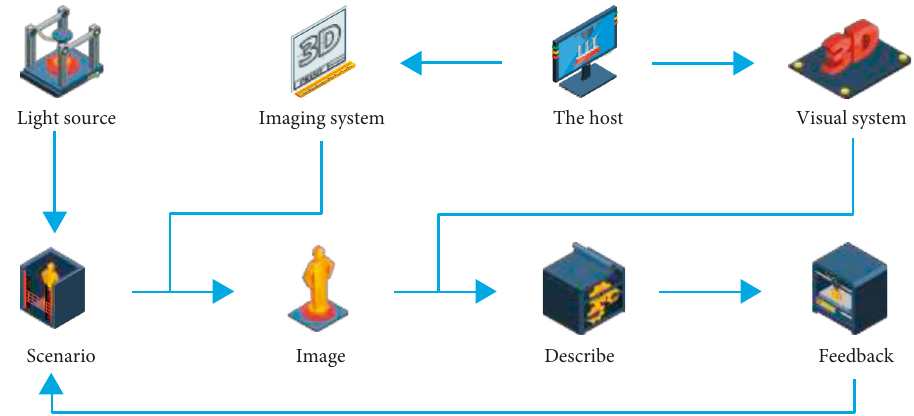
Figure 1: Design of automatic recognition and detection system based on machine